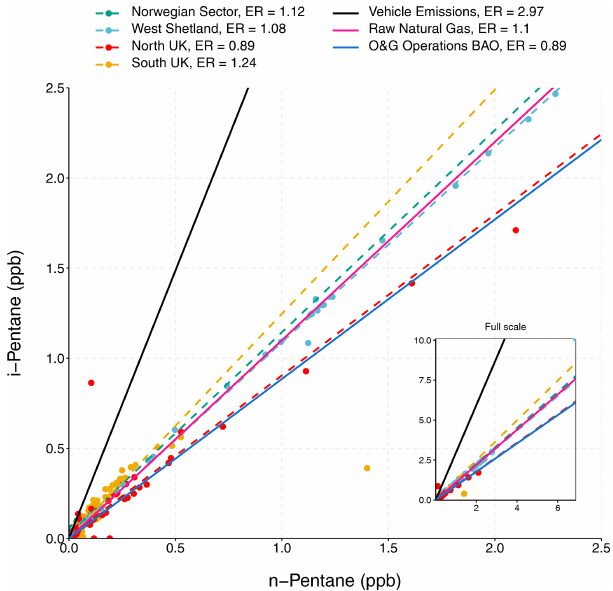
Figure 2. Scatter plot of iso-pentane and n -pentane observations in each sampling region. Dashed lines indicate the linear fit for each region obtained by reduced major-axis regression. The solid black line indicates the ratio from vehicular emissions (von Schnei- demesser et al., 2010), the solid pink line shows the ratio of raw natural gas in the North Sea obtained from the Department for Busi- ness, Energy and Industrial Strategy (BEIS), and the solid blue line indicates a typical ratio from O&G emission sources (Gilman et al., 2013). Inset shows the full range of